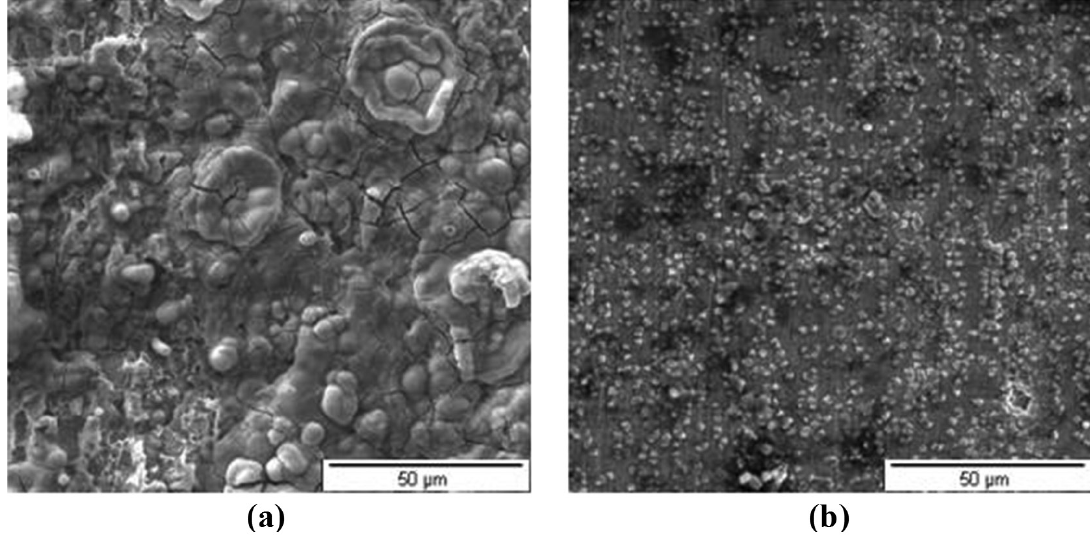
Figure 9. API 5L X80 Steel (1% NaCl, pH 6.5, temperature 60 °C) comparing the surface films formed; (a) under fully immersed conditions and (b) exposed to the adjacent vapour